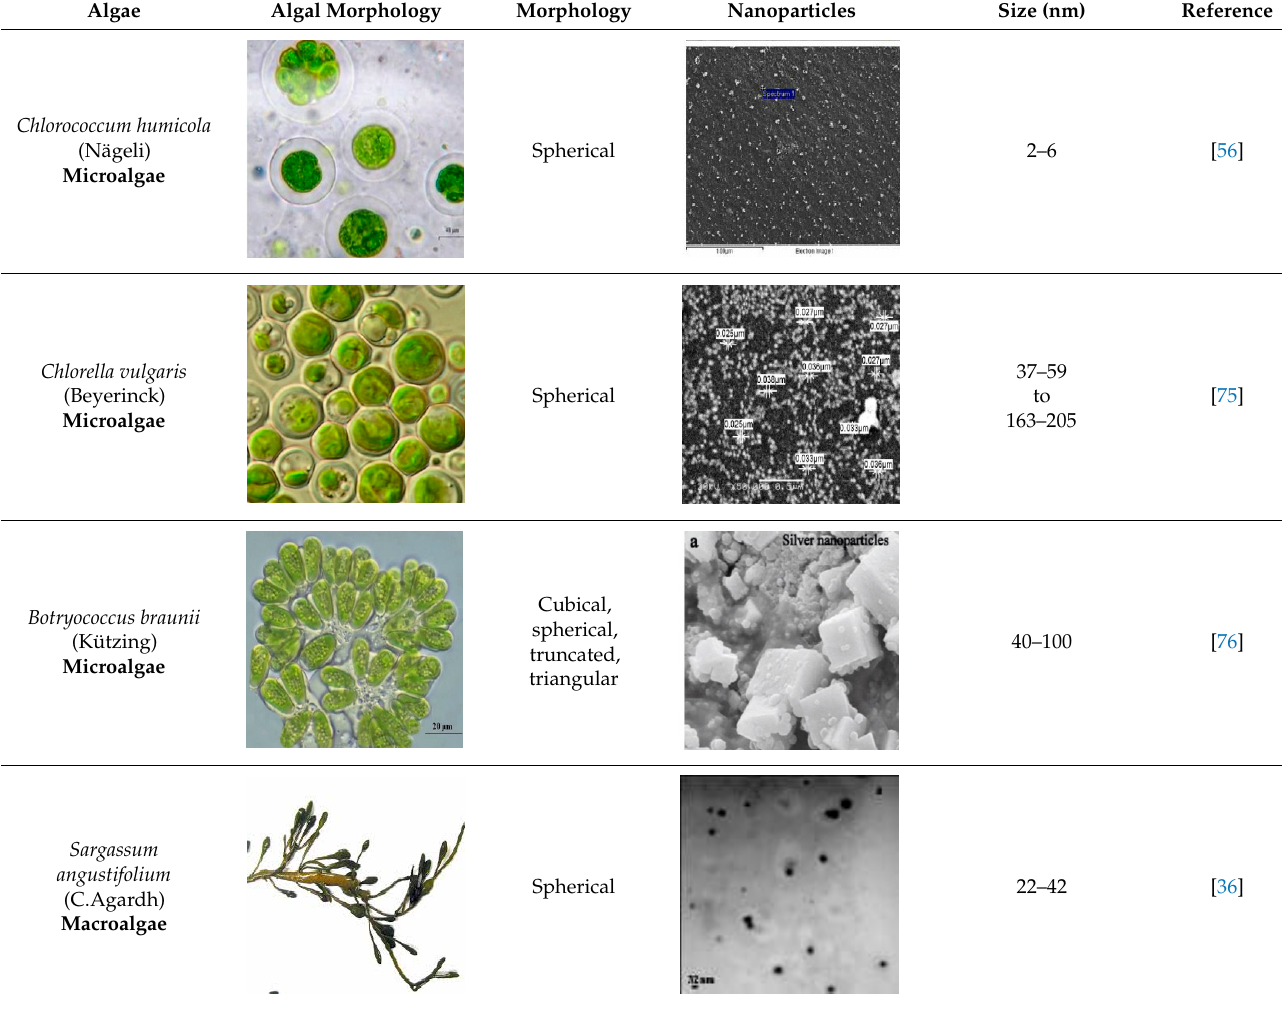
Table 1. Algae-mediated synthesis of silver nanoparticles (AgNPs). (Copyright permission has been granted for each figure). Algae